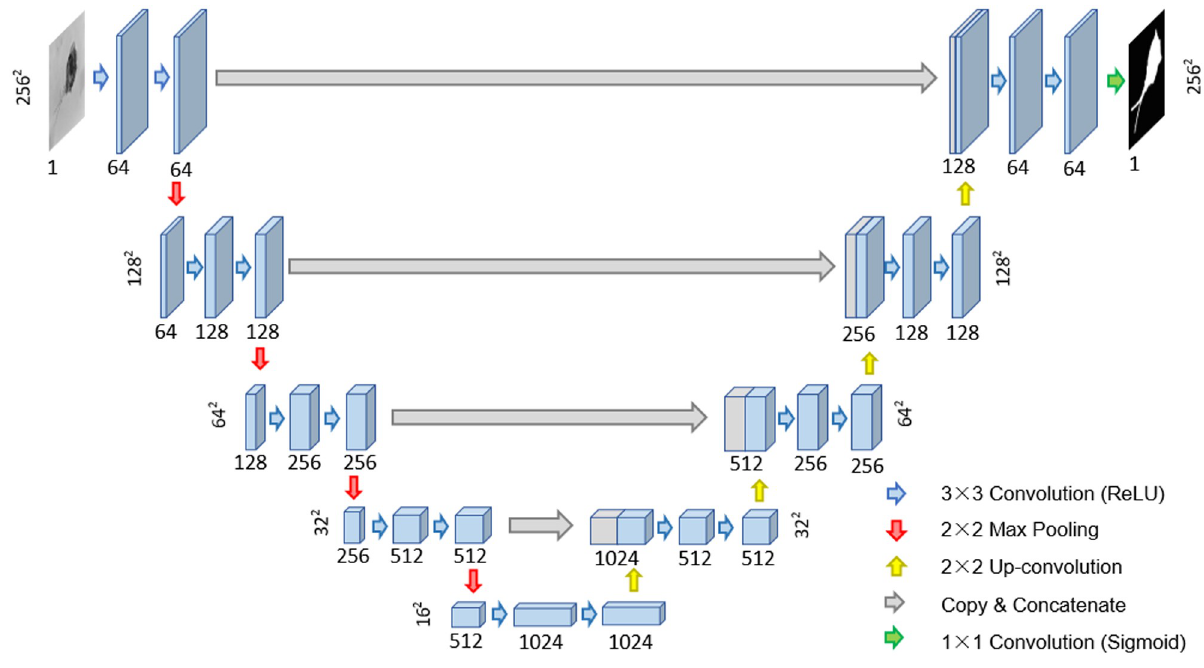
Fig 6. The structure of